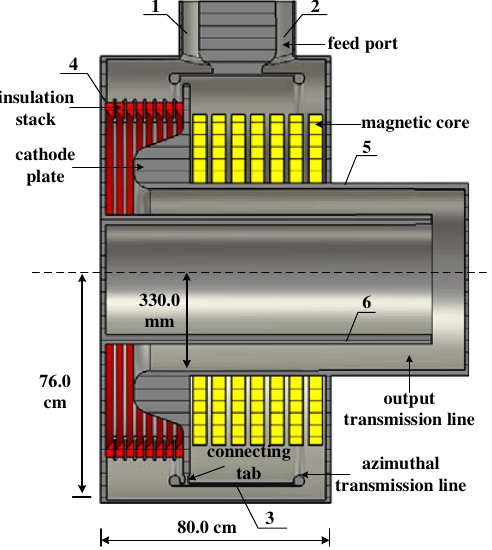
FIG. 1. View of an induction cavity which mainly includes feed port, azimuthal transmission line, connecting tab, insulation stack, magnetic core, cathode plate, and output transmission line. 1 and 2 denote the locations of the D-dot and B-dot monitors which are fielded during our experiment to measure the voltage and current at the feed port, respectively. 3 indicates the positions of the D-dot sensors for azimuthal transmission line voltages measurement, and there are two probes placed at 90 and 180 degrees. The angles are measured in each direction from the midpoint of the feed port. 4 depicts the locations of the two D-dot probes for insulation stack voltages detection at 30 and 90 degrees. 5 represents the locations of the D-dot and B-dot probes for load voltage and current measurement on the output transmission line cathode conductor. At this cross section, two B-dot sensors were employed to detect the load current, and two D-dot probes were used to diagnose the load voltage. They were placed azimuthally. 6 indicates the positions of the D-dot and B-dot monitors on the anode electrode as those on the cathode conductor. There were totally four D-dot monitors measuring the load voltage and also four B-dot sensors diagnosing the load current. The radius and axial lengths of our induction cell were about 760.0 and 800.0 mm,